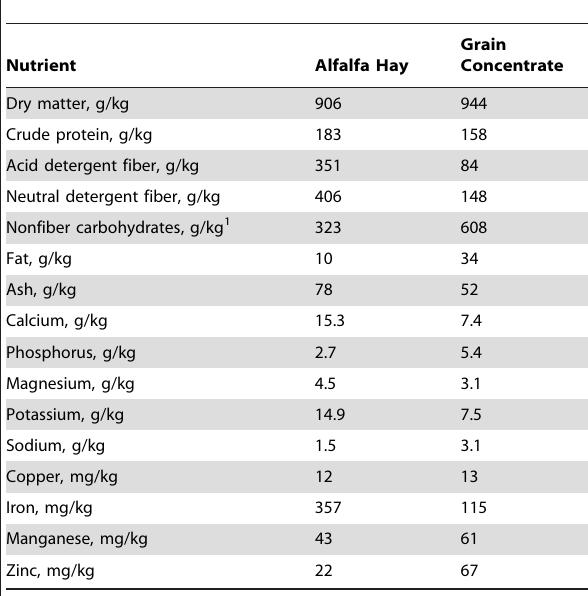
Table 1. Alfalfa hay and grain concentrate nutrient composition (dry matter